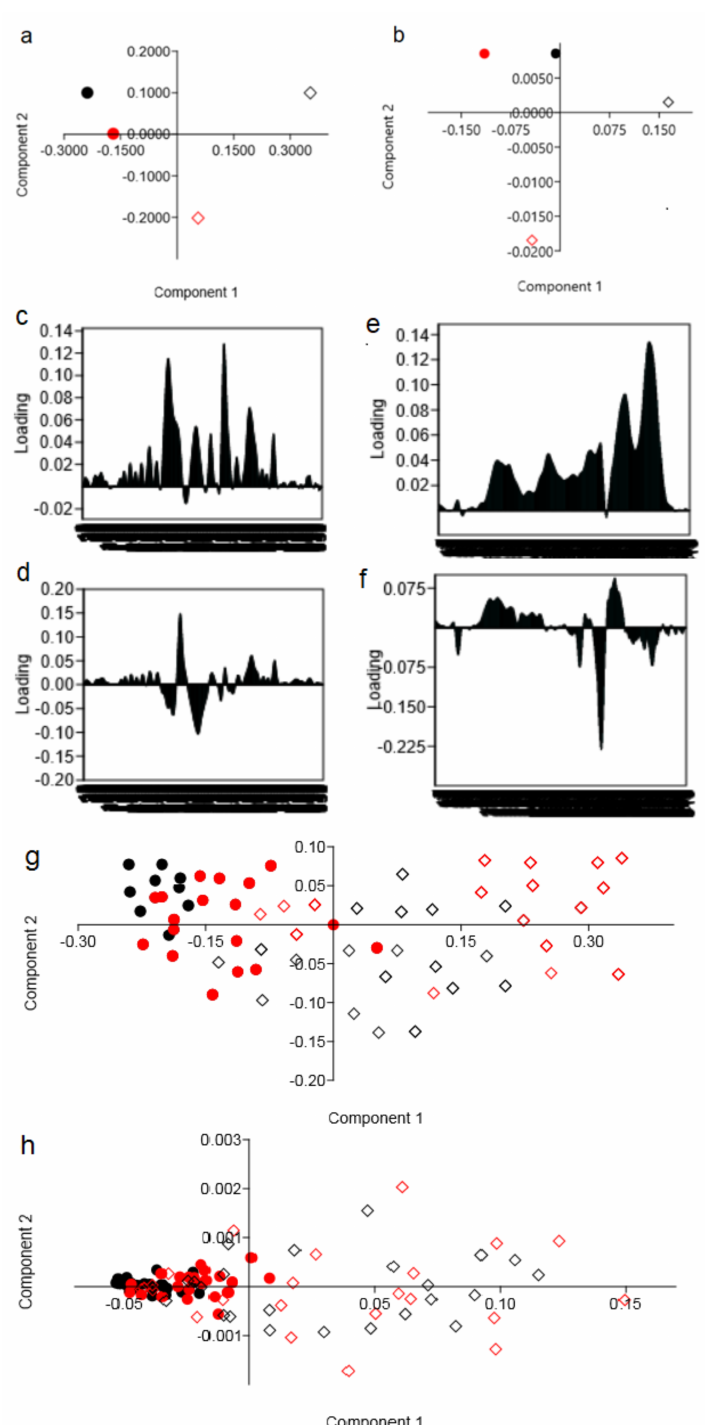
Figure 5. PCA of the breast tissues (black color) and LNs (red color) obtained from the ( a , g ) Raman and ( b , h ) FTIR spectra of the samples from the I (diamond) and II (dot) groups of patients, with loading plots of Components 1 and 2 of Raman ( c , d ) and FTIR ( e , f ). Due to di ff erences in chemical compositions, a two-dimensional (2D) scores plot of the samples is presented through the selected spectral ranges between 800–1800 cm − 1 . Moreover, PCA analysis obtained for average spectra is presented in figures ( a , b ), and PCA analysis for all obtained spectra is presented in ( g , h